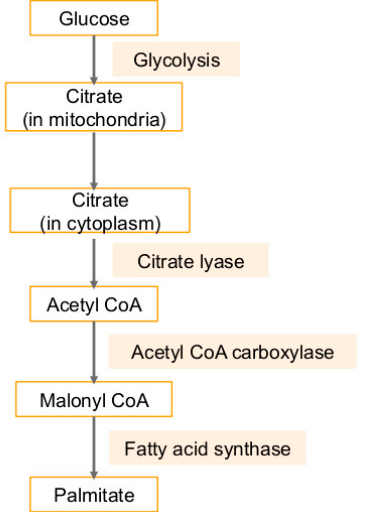
Figure 6. Fatty acid deregulation in pathogenesis of human cancer: A key lipogenic enzyme in fatty acid is fatty acid synthase (FASN), which can be inhibited to downregulate fatty acid synthase to inhibit DNA replication and arrest cell growth.